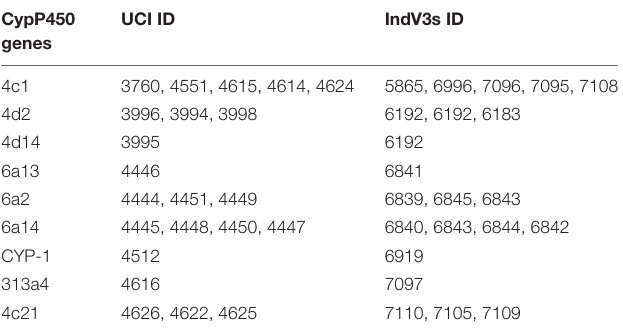
TABLE 2 | List of cytochromes P450 genes within the 2Rb inversion locus in both the UCI and the IndV3 assemblies. CypP450